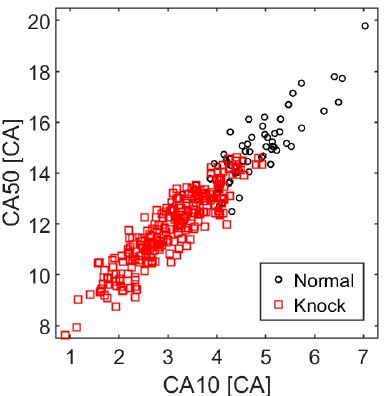
Figure 7. CA10 and CA50 of knock and normal cycles.